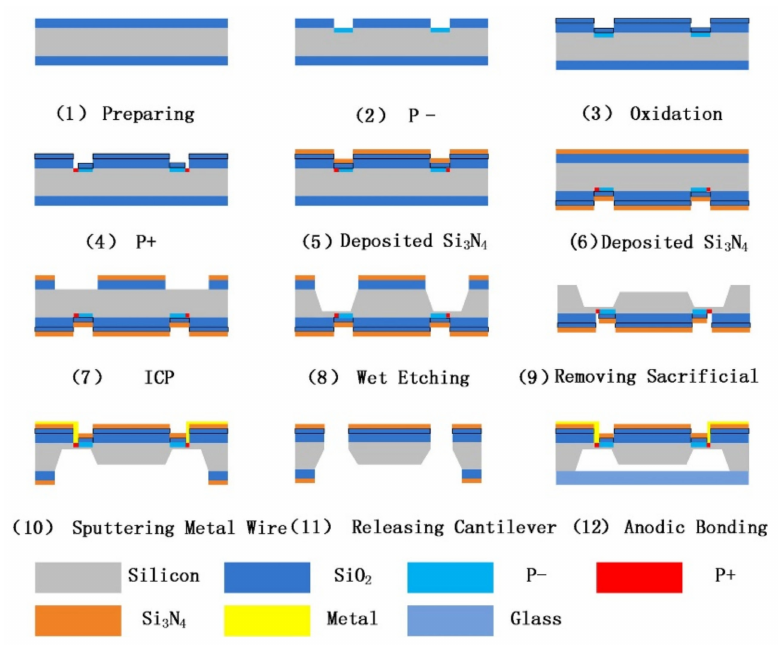
Figure 6. Process of the HGMA.